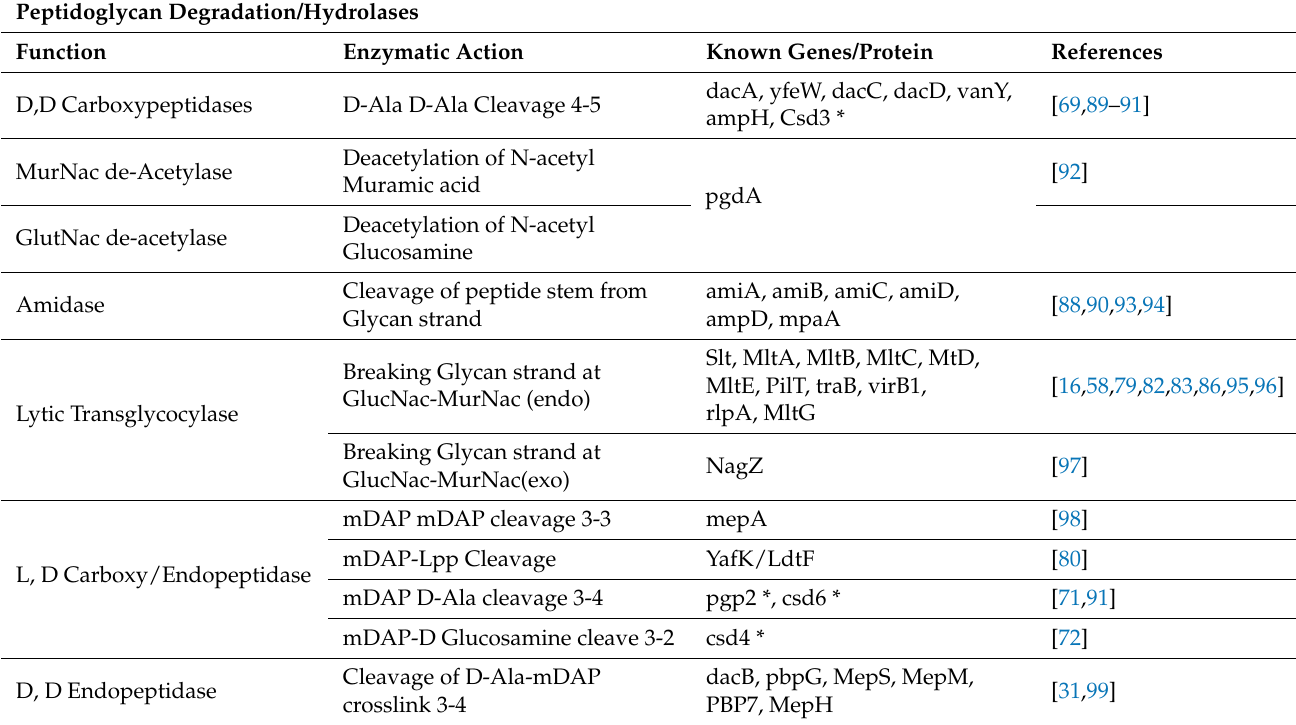
Table A1. Characterised Hydrolases in Gram-negative bacteria.